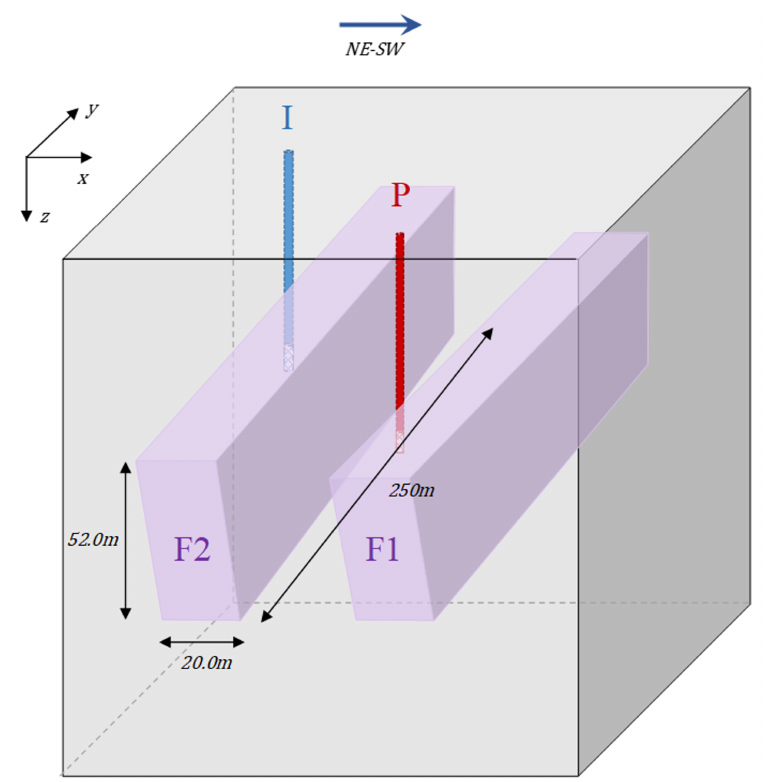
Figure 5. Computational domain in the case of double faults (F1 and